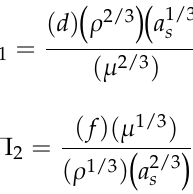
Figure 7. log (Π (cid:2869) ) plotted against Π (cid:2870) . ( a ) Data plotted as dots represent variable conditions at the initiation of droplet spreading for each corresponding liquid, while the data plotted as an “x” represent variable conditions when droplets for each corresponding liquid did not spread. ( b ) The